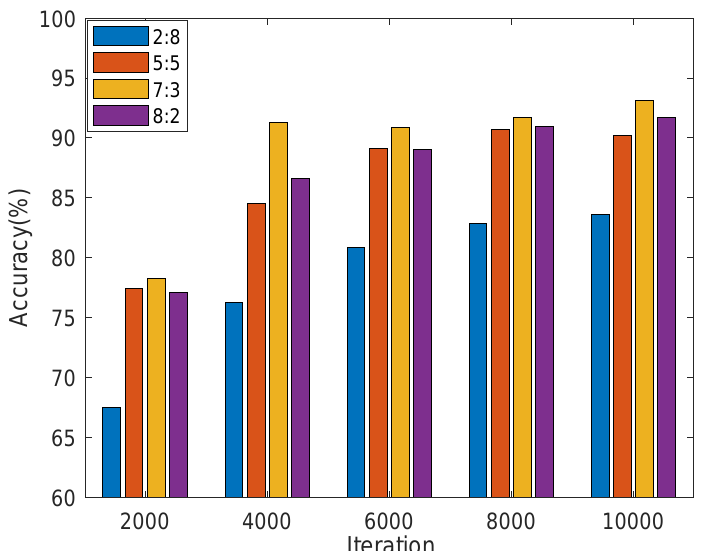
Figure 10. Accuracy under different dataset